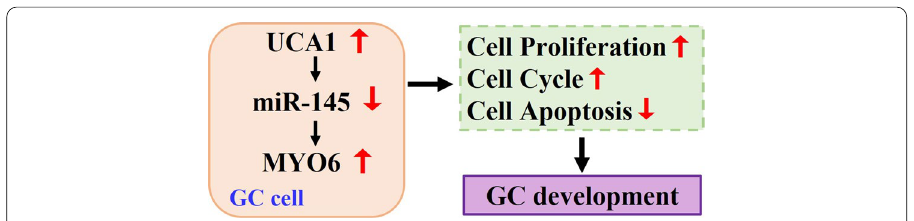
Fig. 10 Schematic representation of UCA1 mediated GC progression through miR-145/MYO6